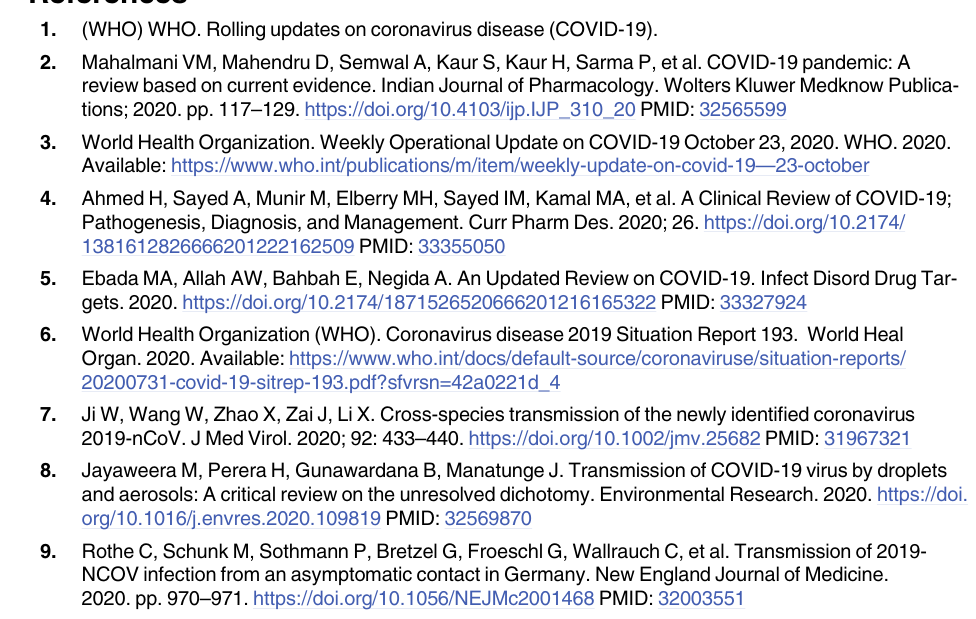
S1 Table. The difference in clinical and laboratory characteristics of the included patients according to